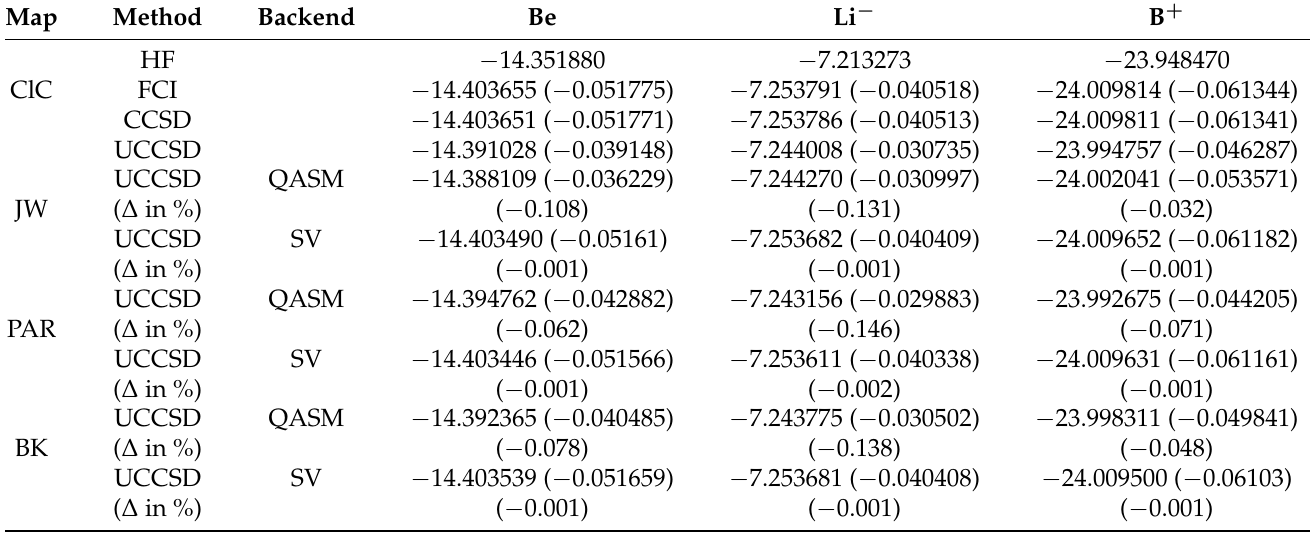
Table 1. A quantitative analysis of the ground state energies (in hartree) of Be, Li − , and B + computed using the variational quantum eigensolver algorithm in the STO-3G basis and adopting the UCCSD ansätz, with different combinations of simulators (statevector (SV) and QASM) and fermion to qubit mapping techniques (JW refers to Jordan–Wigner, PAR to parity, and BK to the Bravyi–Kitaev mapping). The results are compared with values obtained using various methods in a classical computer (ClC). Next to the final values, we provide the correlation energy for that combination in brackets. The percentage fraction difference with respect to FCI results is denoted as ‘ ∆ in